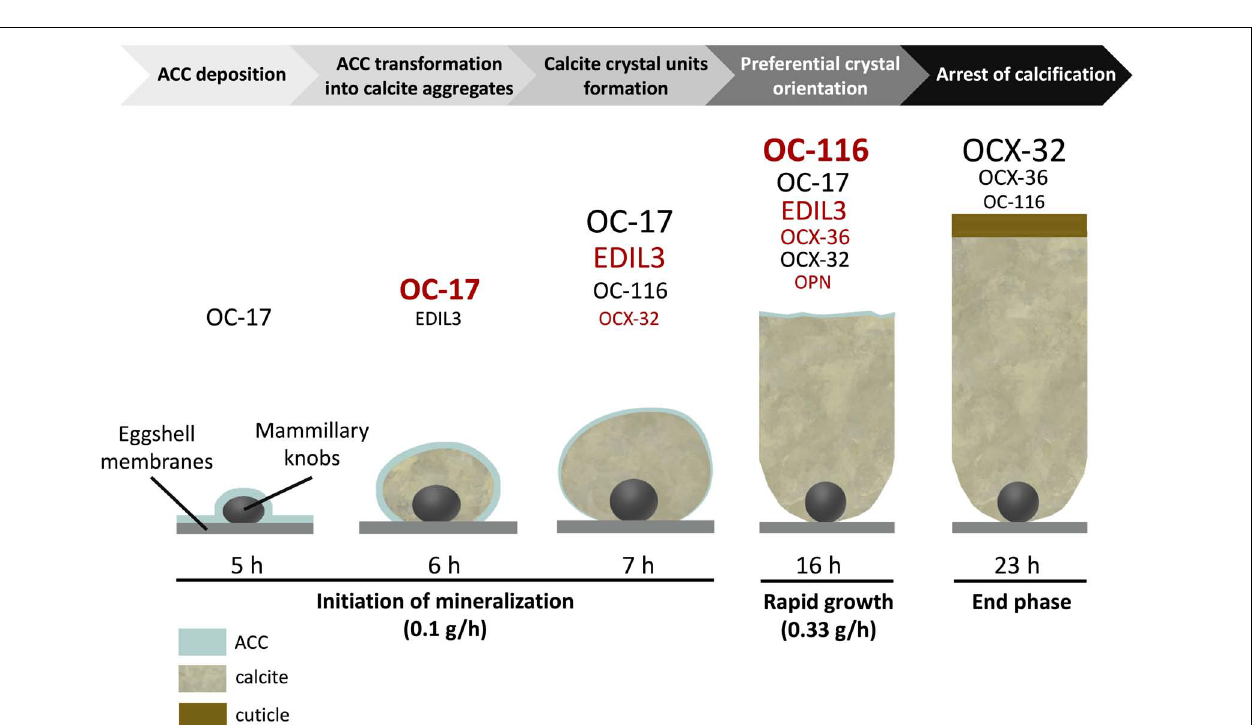
(Blair and Hedges, 2005; Ford and Benson, 2020). Across various bird species, eggshell strength is positively correlated with egg weight (Ar et al., 1979). Guinea fowl shows an elevated strength ( Figure 2 ), which is related to its unique shell